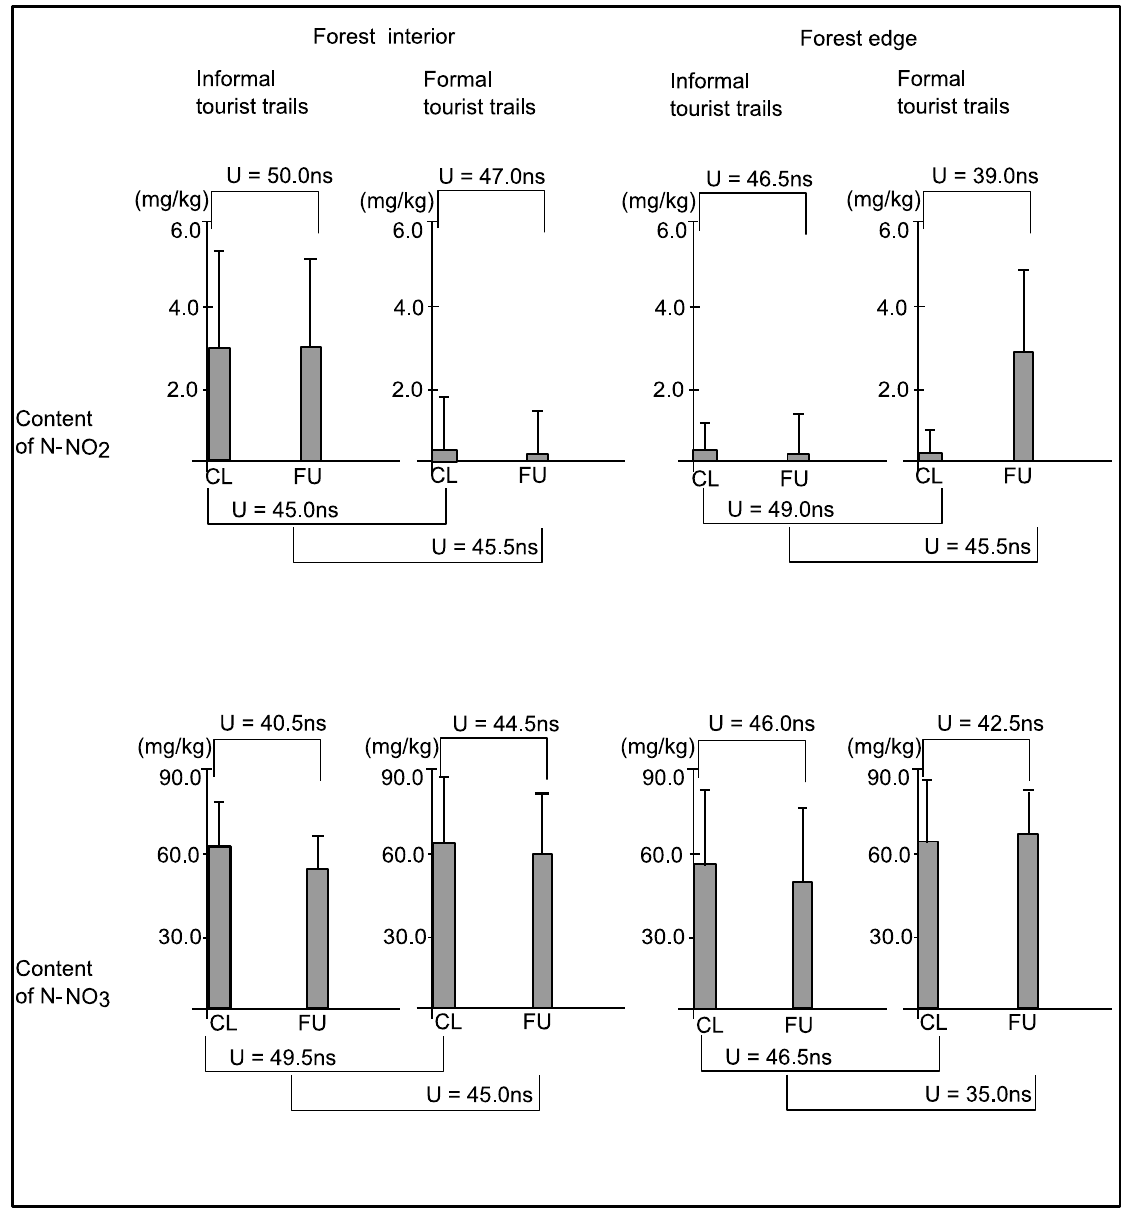
Figure 5. The mean content of nitrite N-NO 2 and nitrate N-NO 3 (±SD) in soil samples of closer (CL) and further (FU) plots located along informal (width < 50 cm) and formal (width > 150 cm) tourist trails within the forest interior and forest edge sites. The statistical significance level is explained in Figure 2.